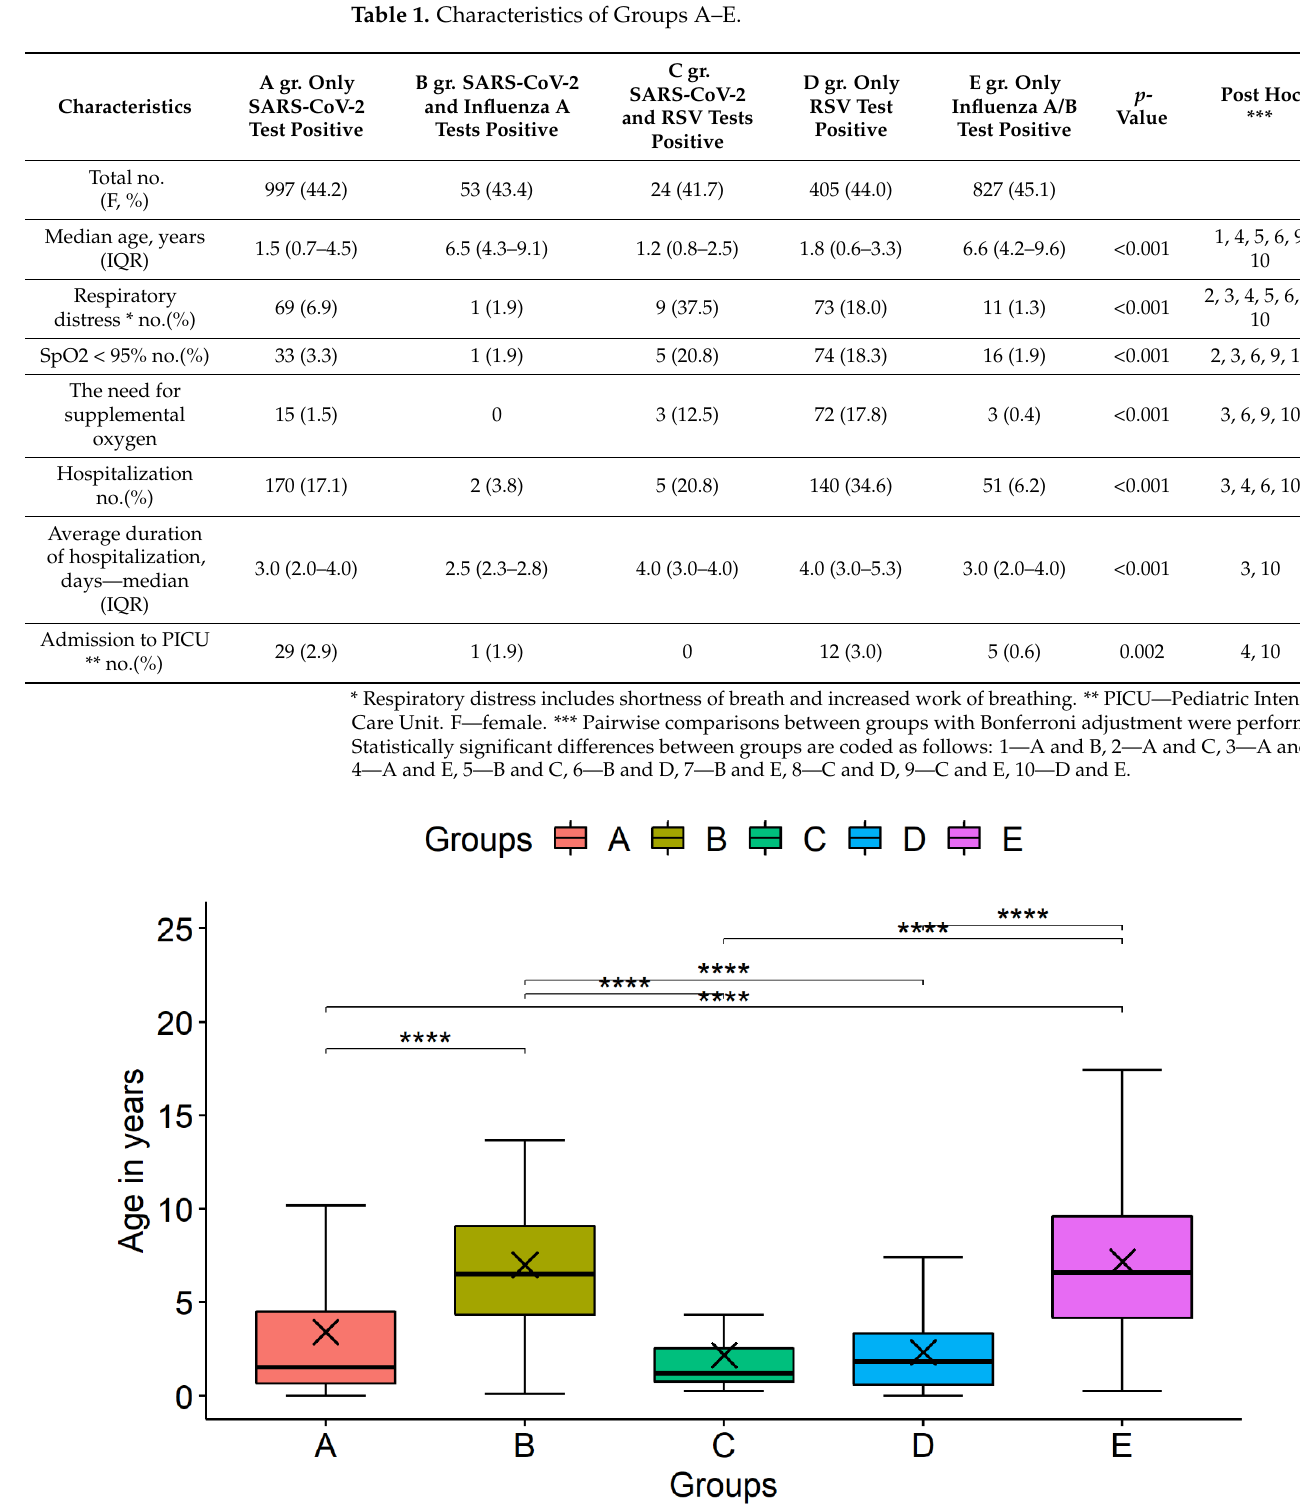
Table 1. Characteristics of Groups A–E.